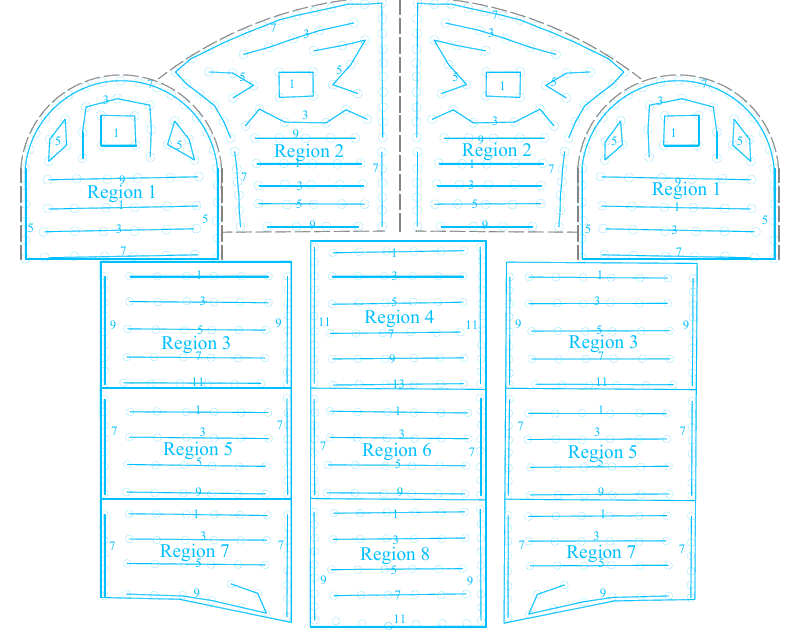
Figure 4. Layout of blast holes.